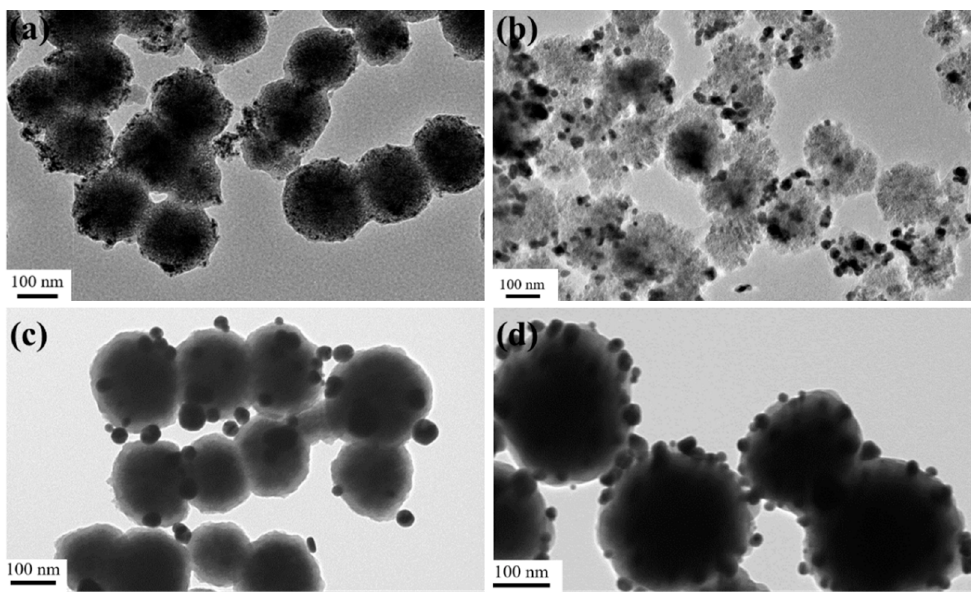
Figure 3. TEM images of the Fe 3 O 4 @PDA/Au/PDA with the 200 nm Fe 3 O 4 ( a ), Fe 3 O 4 @PDA/Au-Ag with the 200 nm Fe 3 O 4 ( b ), Fe 3 O 4 @PDA/Ag with the 200 nm Fe 3 O 4 ( c ), and Fe 3 O 4 @PDA/Ag/PDA with the 300 nm Fe 3 O 4 ( d ).